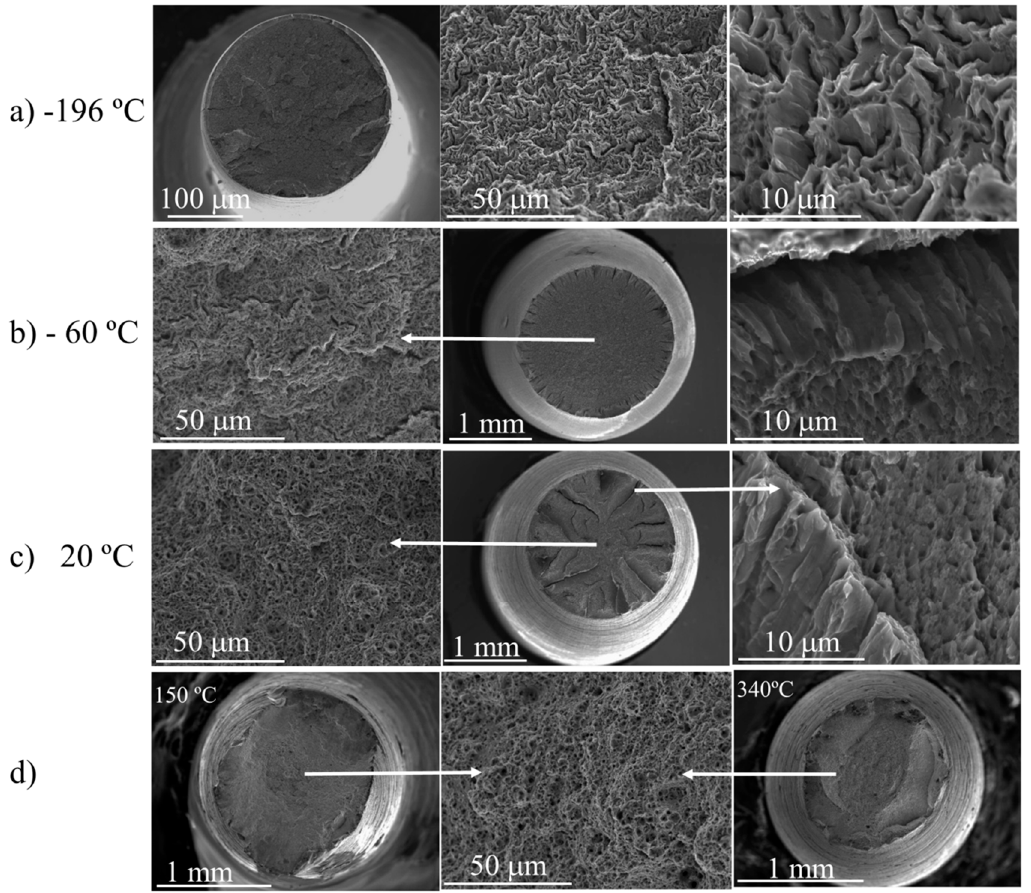
Figure 6. ( a ) SEM images in progressively higher magnifications of the fracture surface of tensile specimens tested at − 196 °C; ( b ) SEM images of the fracture surface of tensile specimens tested at − 60 °C, showing the fractographic features at the center of the cross section ( left ) and at the edge near the delaminations ( right ); ( c ) SEM images of the fracture surface of tensile specimens tested at +20 °C, showing the fractographic features at the center of the cross section ( left ) and at the edge near the delaminations ( right ); ( d ) SEM images of the fracture surface of tensile specimens tested at +150 °C ( left ), 340 °C ( right ), and representative fractographic features at high magnification ( middle ).